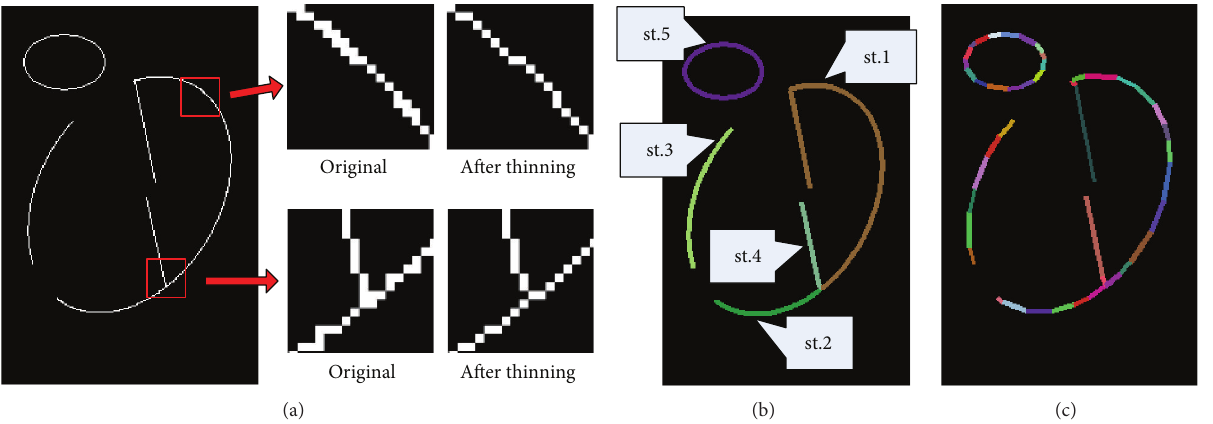
Figure 3: The process of line segment extraction. (a) Number of neighboring pixels decreases after morphological thinning. (b) Extracted strips after edge linking; each color corresponds to a strip. (c) Line segments extracted from strips; each color corresponds to a line